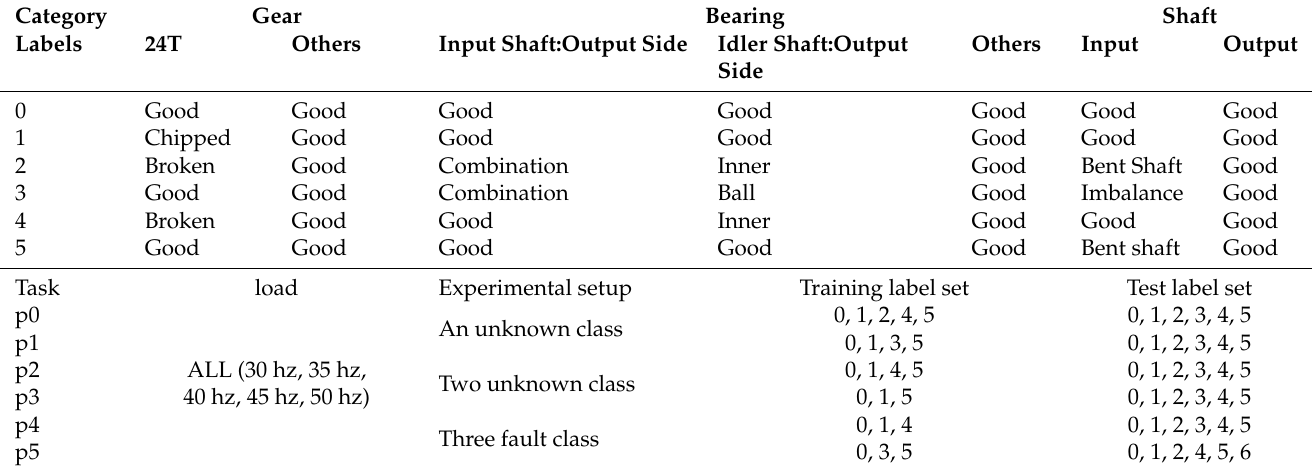
Table 5. The information of the PHM2009 and specific task